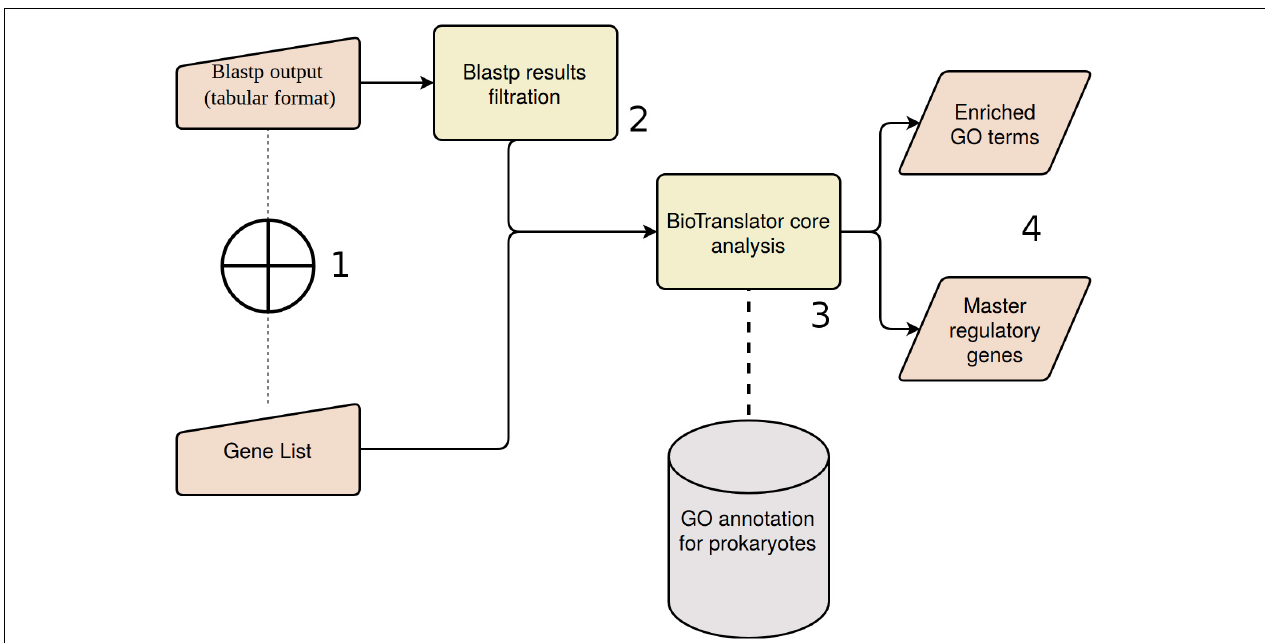
FIGURE 4 | BioTranslator workflow. (1) User could start the analysis with a pre-defined gene list, or sequence similarities derived from Blastp analysis. (2) Blastp results are filtered if the initial input is the respective tabular file. (3) Pathway analysis and master regulators detection are based on BioTranslator core algorithms. (4) Final outputs of BioTranslator analysis.